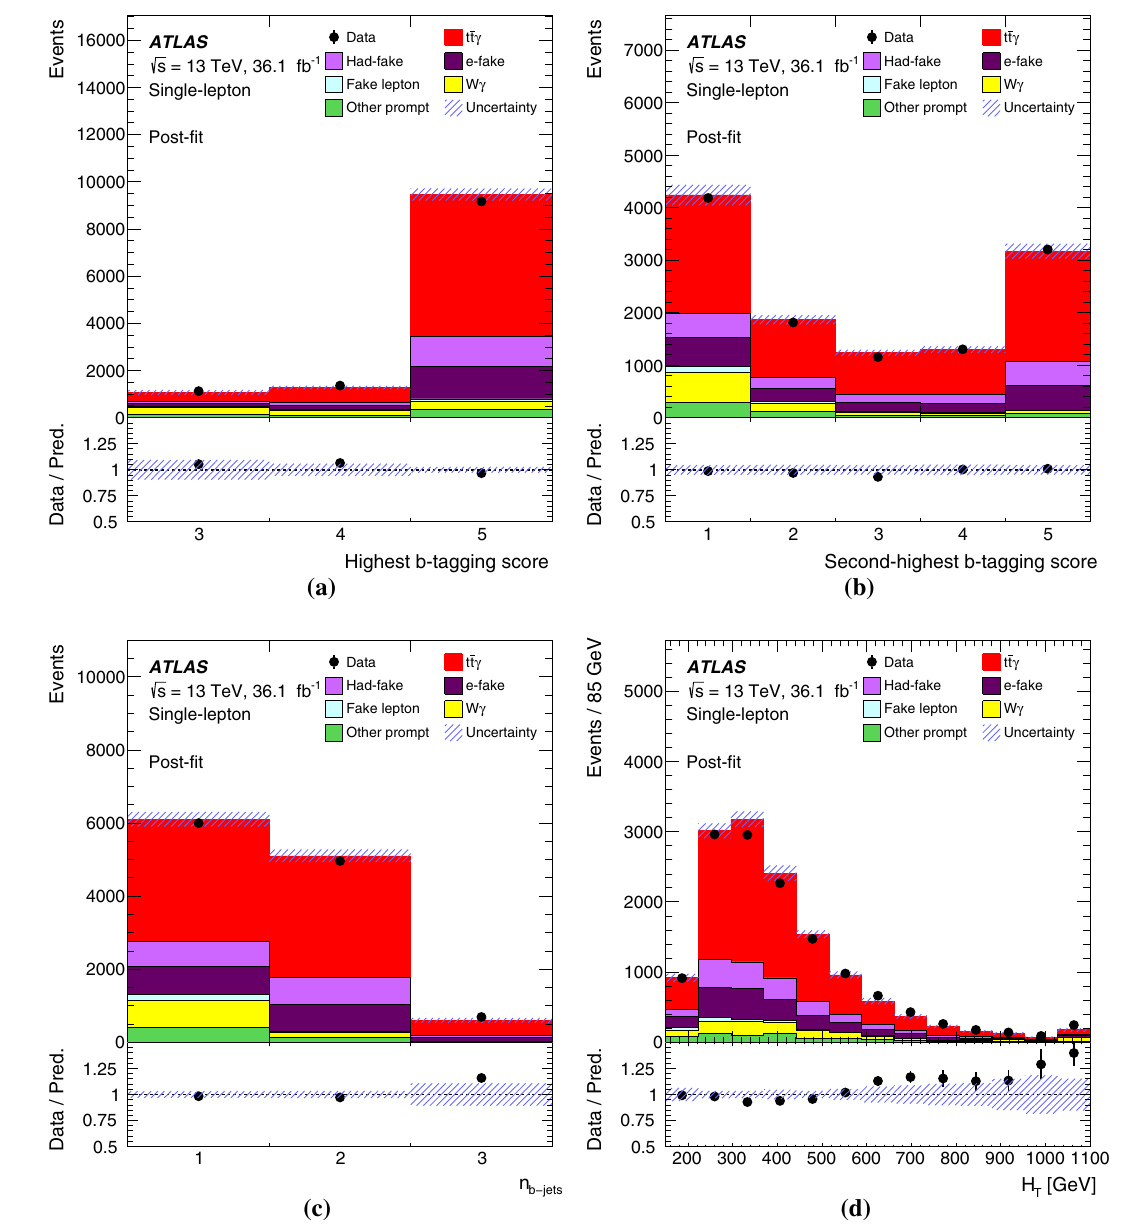
Fig. 14 Distributions of the a highest and b second highest b -tagging scores for all jets, c total number of b -tagged jets (at a 77% efficiency), and d scalar sum of the transverse energies of all the selected physical objects in the single-lepton channel after event selection and likelihood